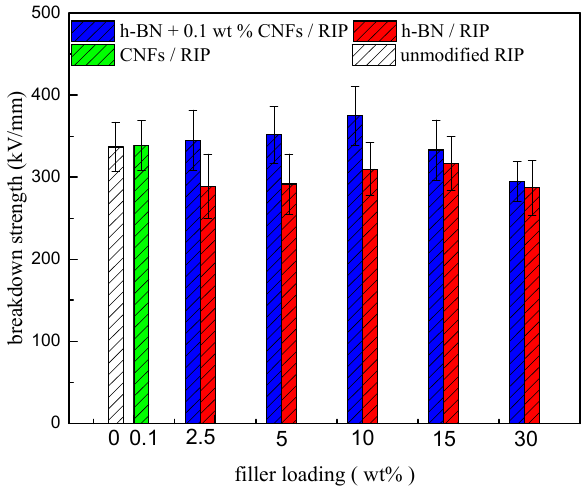
Figure 6. DC breakdown strength of unmodified RIP, BN/RIP, CNF/RIP, and BN + 0.1 wt % CNF/RIP.